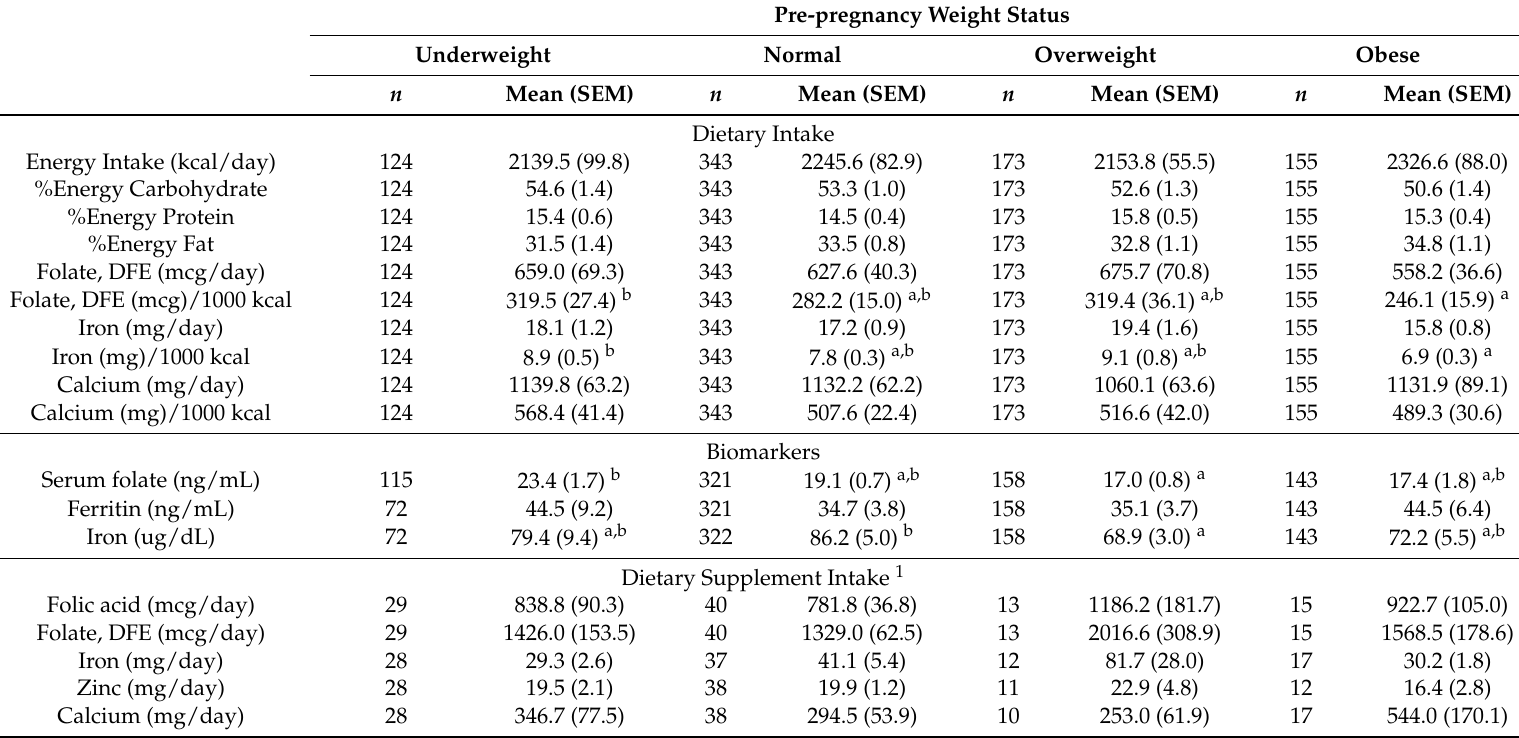
Table 4. Dietary intake and diet-related biomarkers during pregnancy across categories of pre-pregnancy weight